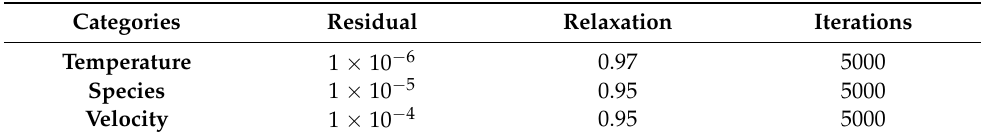
Table 4. Residuals